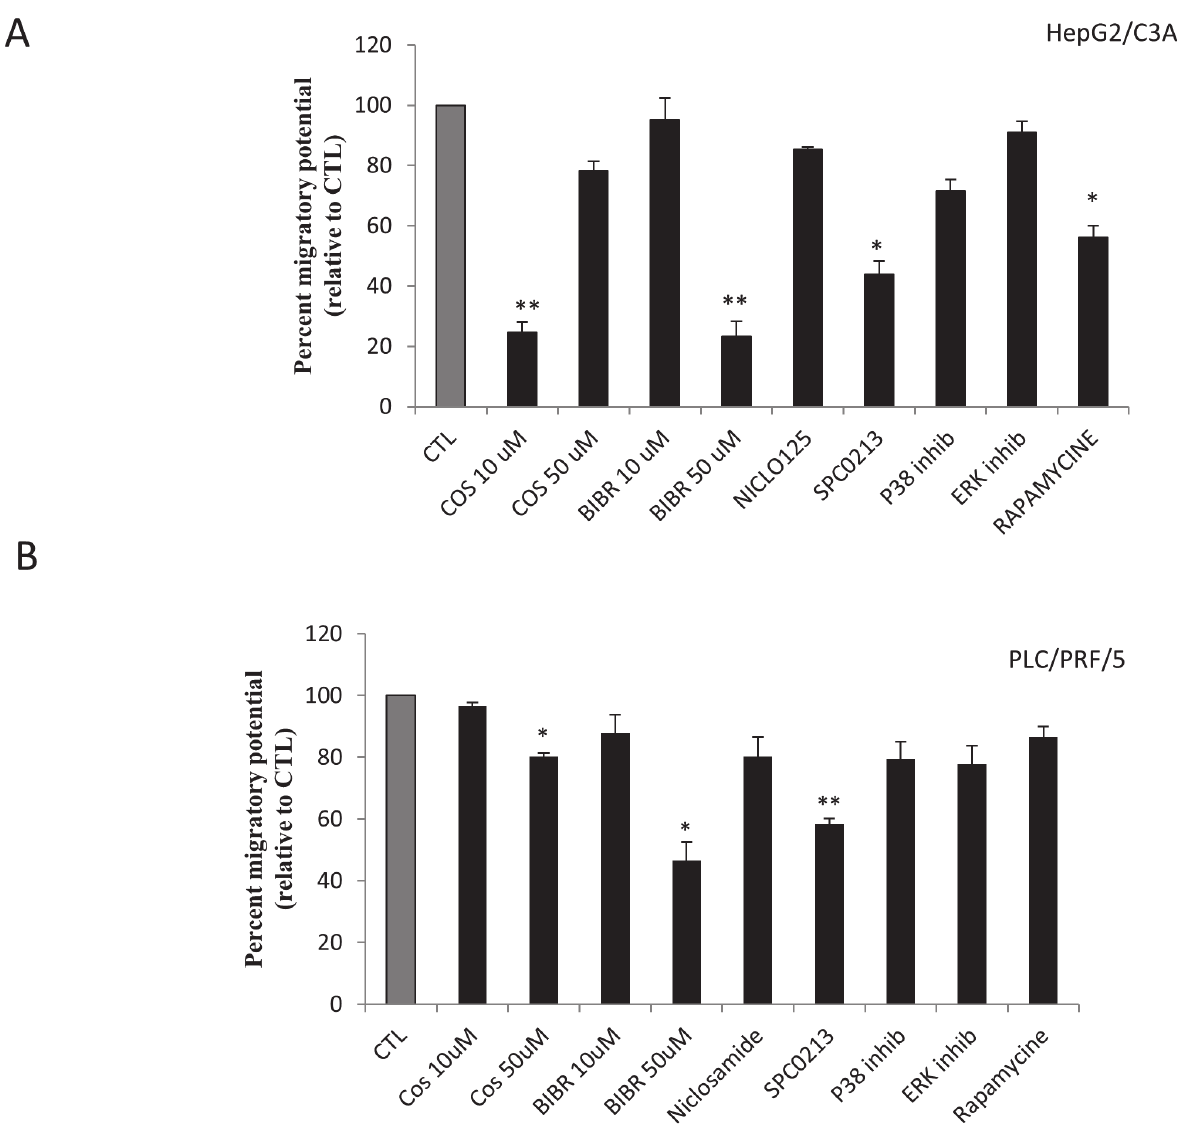
Fig 4. Effect of telomerase, mTOR and PKC inhibitors on HepG2/C3A and PLC/PRF/5 cell migration. The migration of HepG2/C3A and PLC/PRF/5 cells was assayed using the Boyden chamber technique in a 24-well plate. According to the manufacturer ’ s recommendations, 10 6 cells in DMEM without serum were suspended in the upper chamber of each well; in the lower chamber, DMEM + 10% FBS was added as a chemo-attractant solution. After 24 h of treatment, the cells that migrated to the lower chamber were stained using a staining solution that fixes and stains the cell walls and cytoplasmic membranes of any cell remaining on the insert. The stain is instantly dissolved once the kit extraction solution is added. The solution was then transferred to a 96-well microtiter plate, and the absorbance was measured at 560 nm using a plate reader. (A) Costunolide (10 μ M), BIBR (10 μ M), rapamycin (200 nM) and SPC0213 (5 μ M) had a significant effect on HepG2/C3A cell migration after treatment for 24 h. (B) Costunolide (50 μ M), BIBR (50 μ M) and SPC0213 (5 μ M) had a significant effect on PLC/PRF/5 cell migration after treatment for 24 h. Each value represents the mean of three assays. Each value was normalized to its own control, which was set to 100%. Each point represents the mean ± SD from all of the experiments. * P < 0.01 versus untreated cells. ** P < 0.005 versus untreated